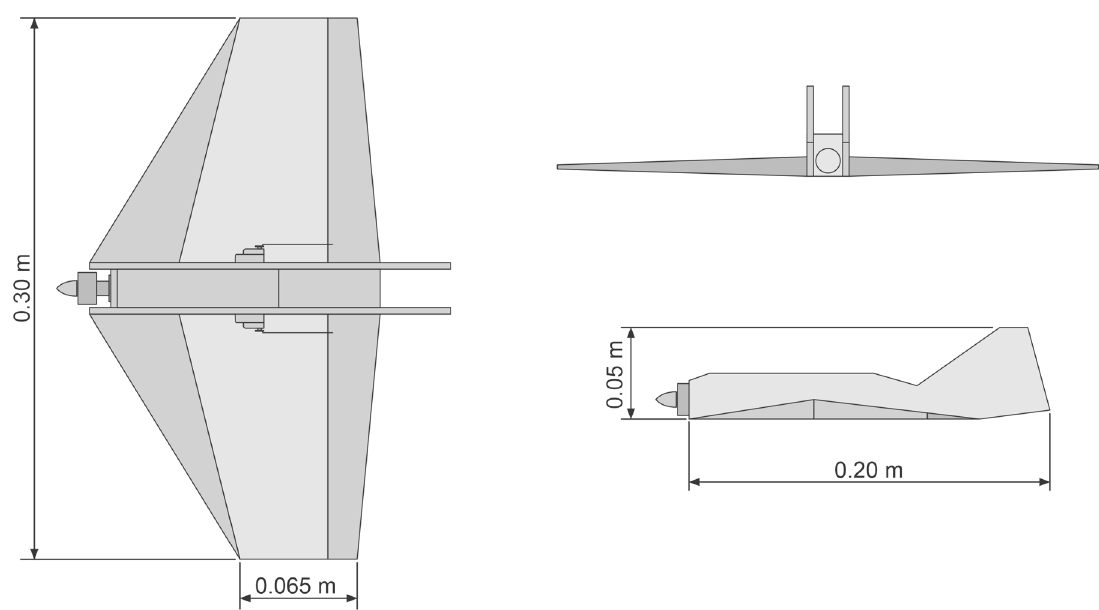
Figure 6. Prototype 5 is our first Delta shaped model tested, also made with extruded